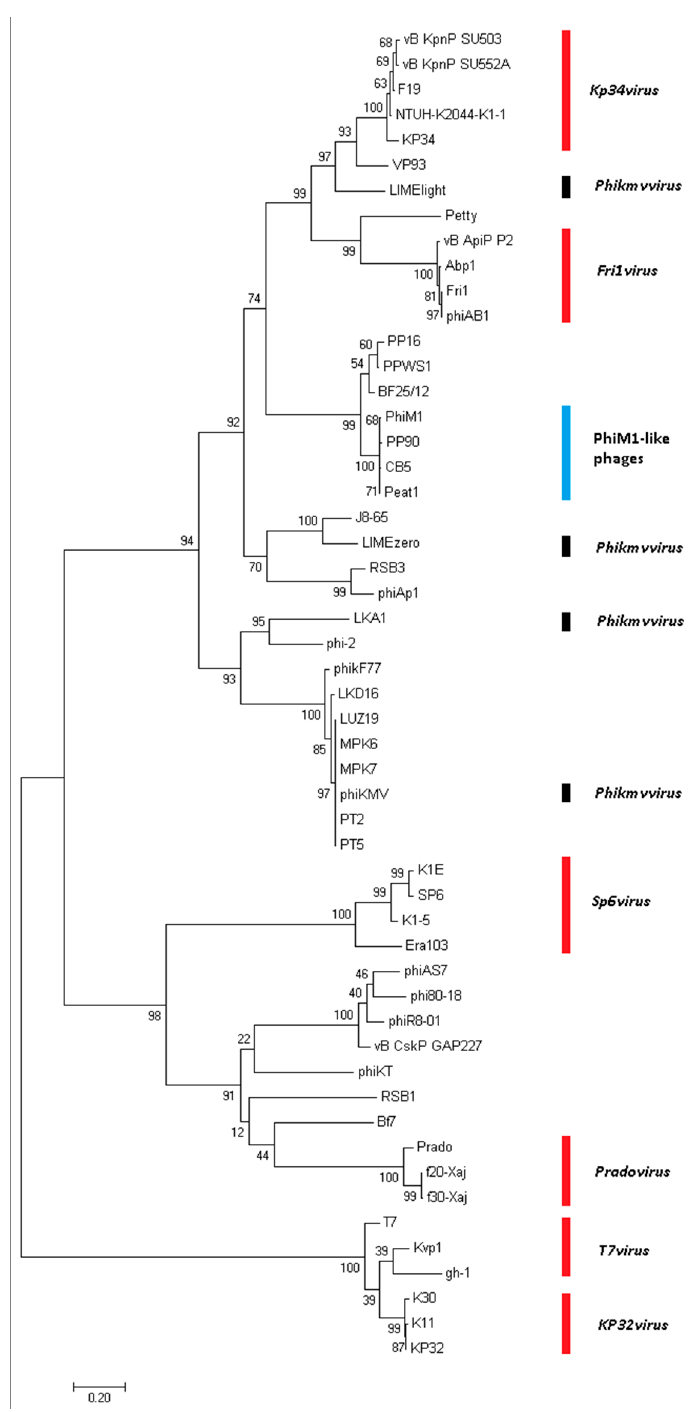
Table S4). Further analysis using Gegenees (TBLASTX), based on protein similarity, indicate the PhiM1-like phages form a clade with high identity values of ≥ 80%. Additionally, as seen in the phylograms, it was observed that P. carotovorum subsp. carotovorum phages PP16 and PPSW1 and Dickeya phage BF25/12 share an evolutionary relationship with PhiM1-like phages (identity values ≥ 54%) (Figure 7).